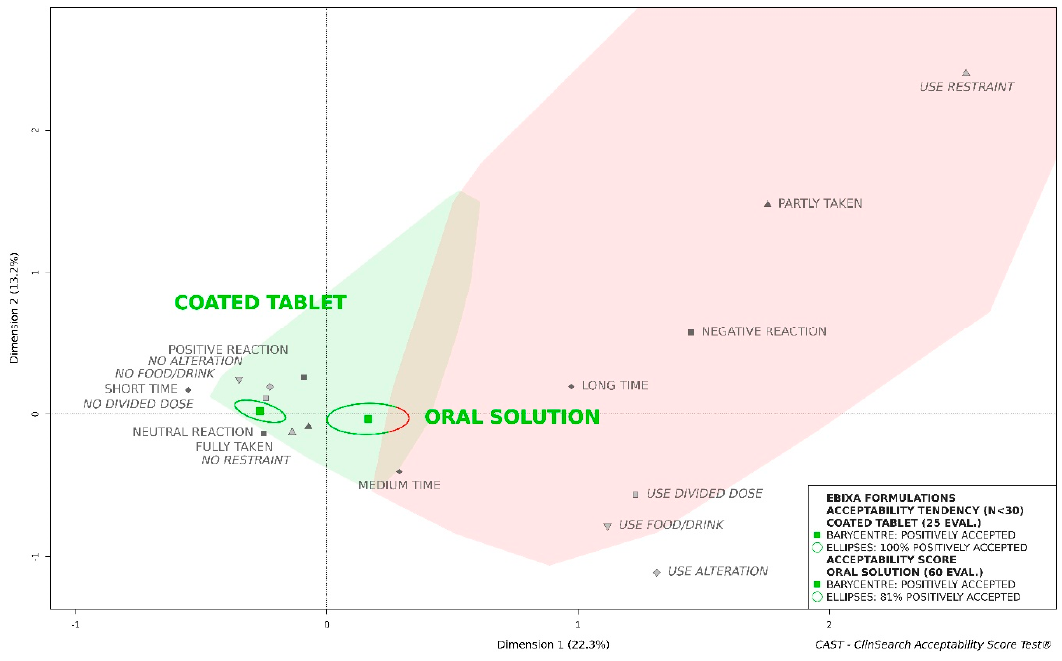
Figure 1. Acceptability of the original formulations of memantine (Ebixa ® ) in the older population.